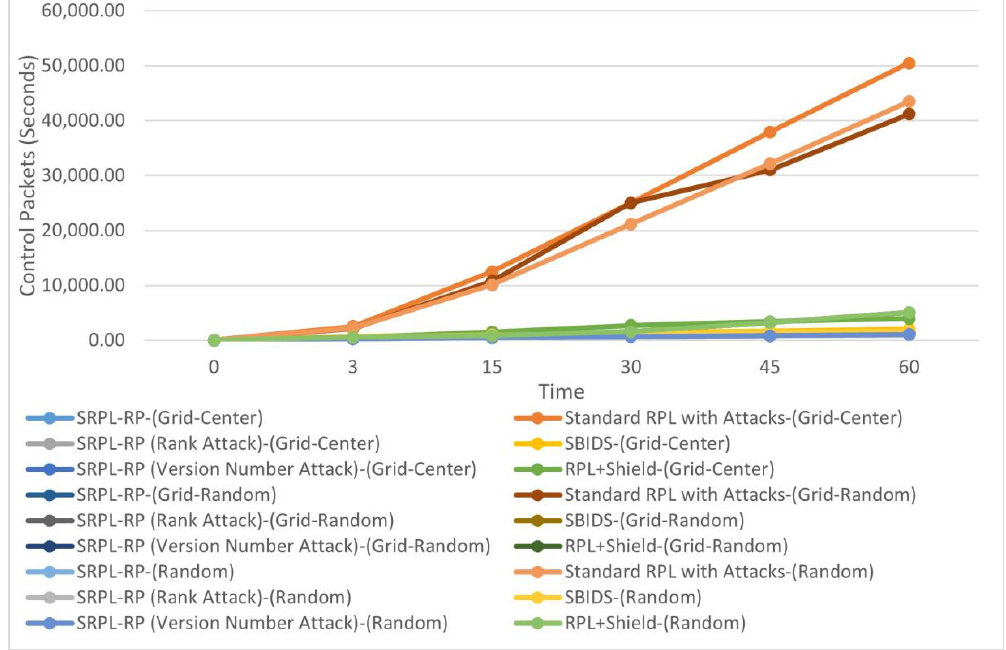
Figure 4. Control Message Comparison in Three Topologies. Table 6. Control Message Comparison in Grid-Center Topology.